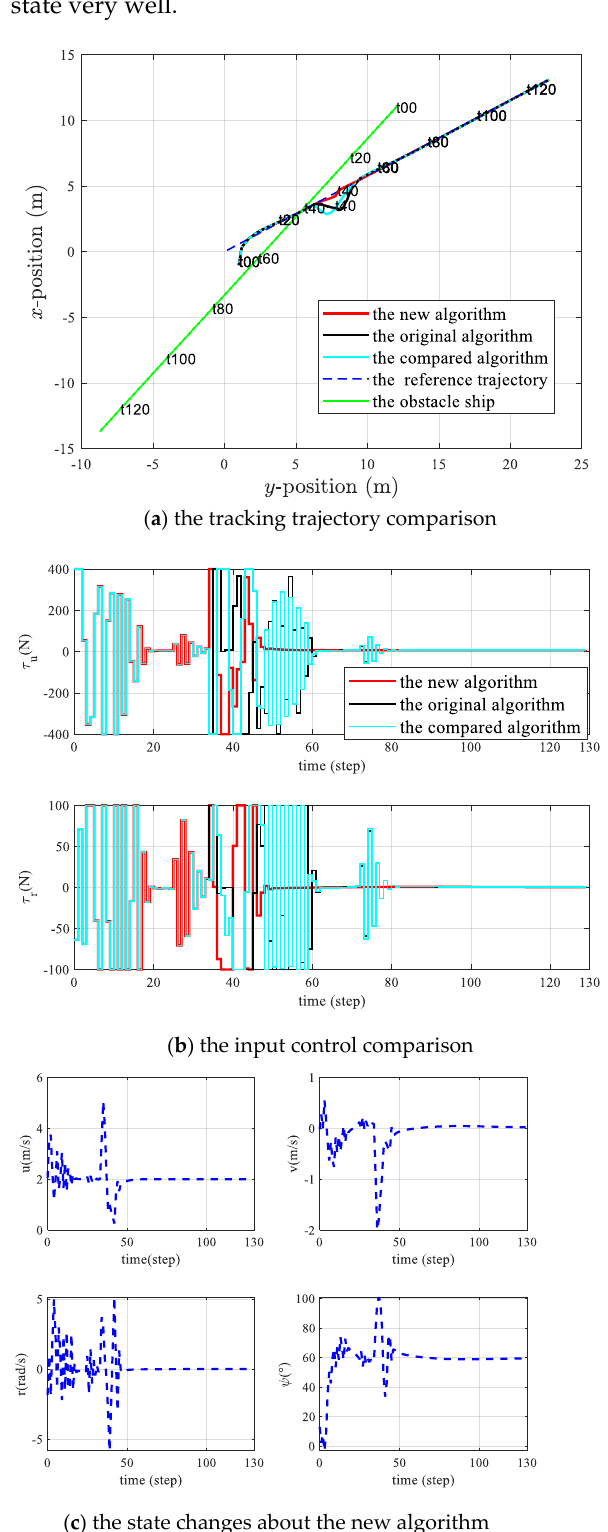
Figure 5. Comparison of algorithms under single obstacle ship.